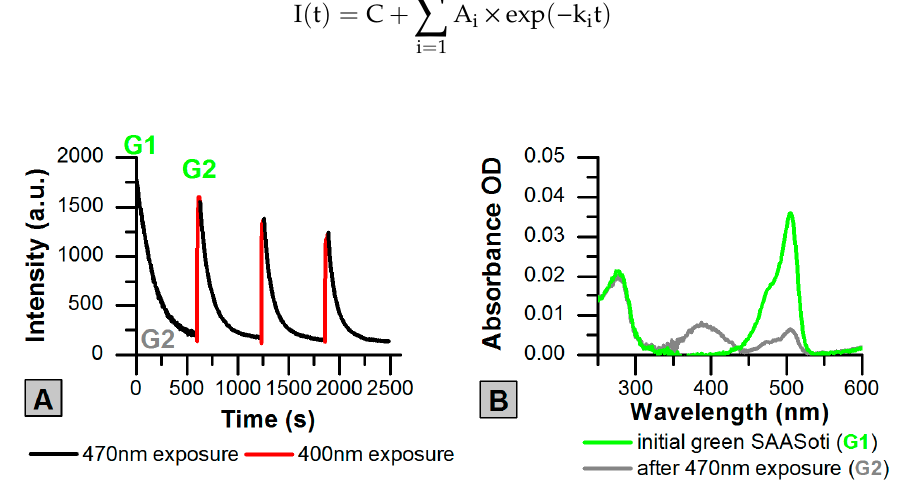
Figure 2. Reversible photoswitching of the green SAASoti (0.5 µM). 470 nm illumination 160 mW/cm 2 (10 min) and 400 nm 5.7 mW/cm 2 (10 s), pH 9.2, 200 mM NaHCO 3 . ( A ) Fluorescence time dependencies; ( B ) Absorbance spectra of ‘on’ (green) and ‘o ff ’ (grey) fluorescent states of SAASoti intensity at 520 nm time dependencies; ( B ) Absorbance spectra of ‘on’ (green) and ‘off’ (grey) after first switching fluorescent states of SAASoti after first switching cycle.